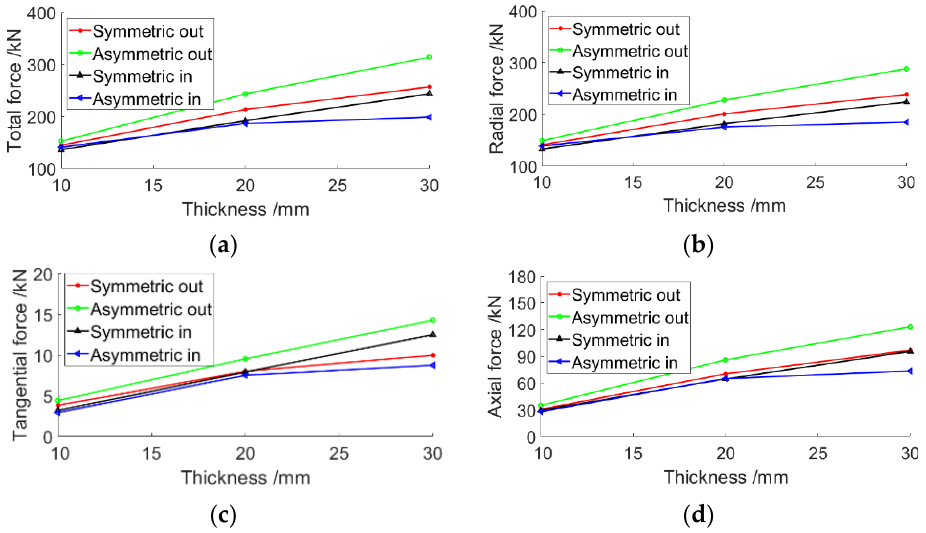
Figure 11. The influence of tube blank thickness on flow-forming force: ( a ) Total force; ( b ) Radial force; ( c ) Tangential force; ( d ) Axial force. (out: outer roller; in: inner